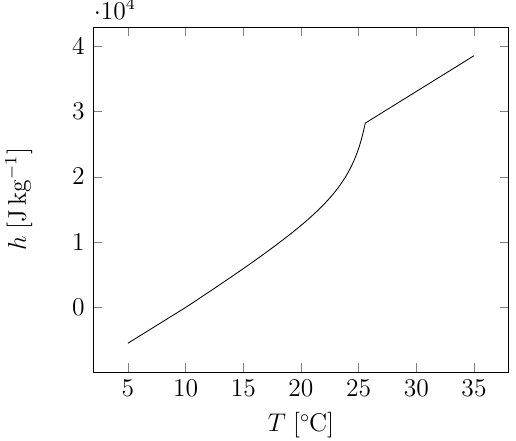
Figure 6. 12.4% w -PCM mortar: identified enthalpy function for the first cycle of the 2h heating/cooling ramp ( n.b. unique formulation pertaining for both fusion and